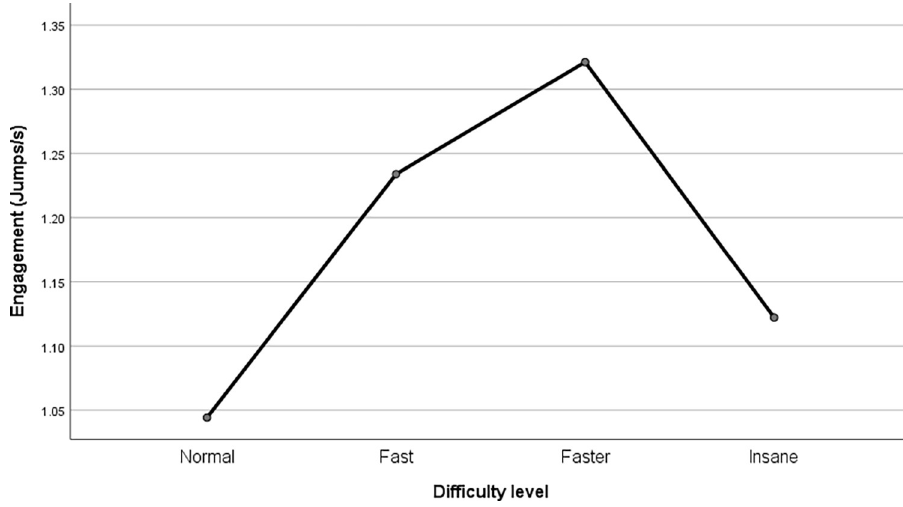
Fig 5. Behavioral index of involvement in the game depending on the level of difficulty–the intensity of space hits (jumps) per second of gameplay.